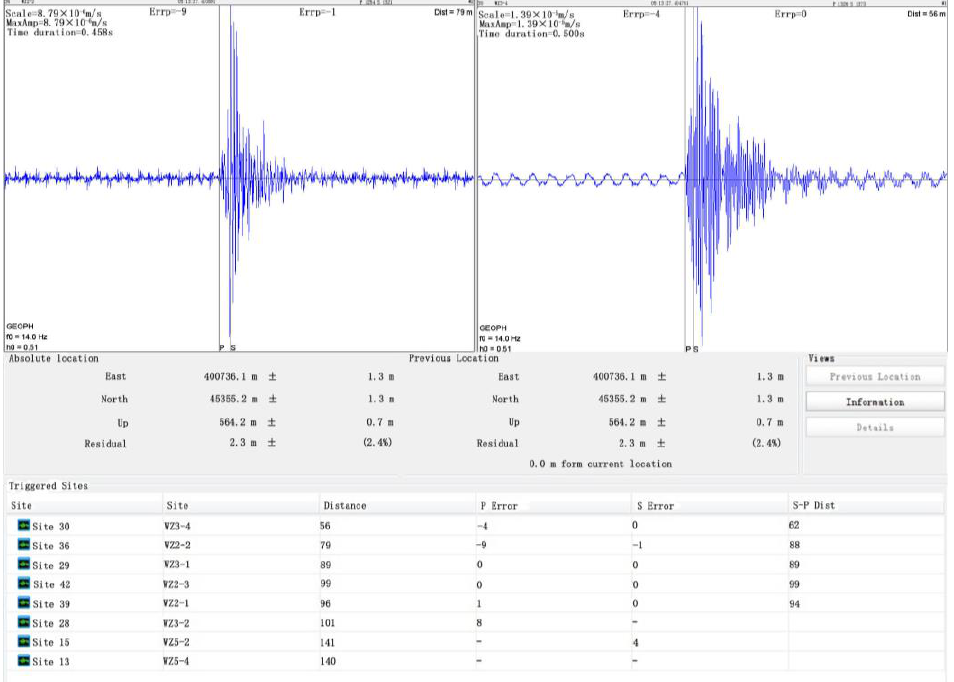
Figure 2. Calibration blast waveform and positioning results. Table 1. Calibration of blasting information and positioning results .